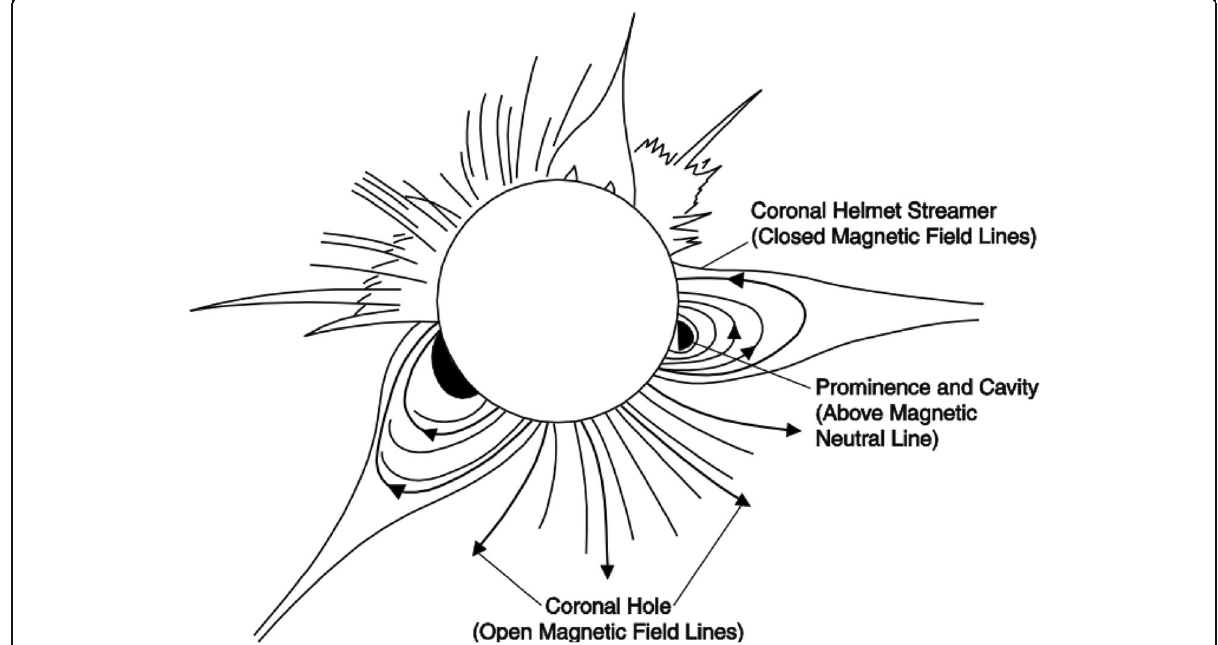
Fig. 29 Sketch of the open-closed magnetic field structures on the Sun. Adapted from Fig. 4.8 of the book “ Introduction to Space Physics ” edited by Kivelson and Russell et al.